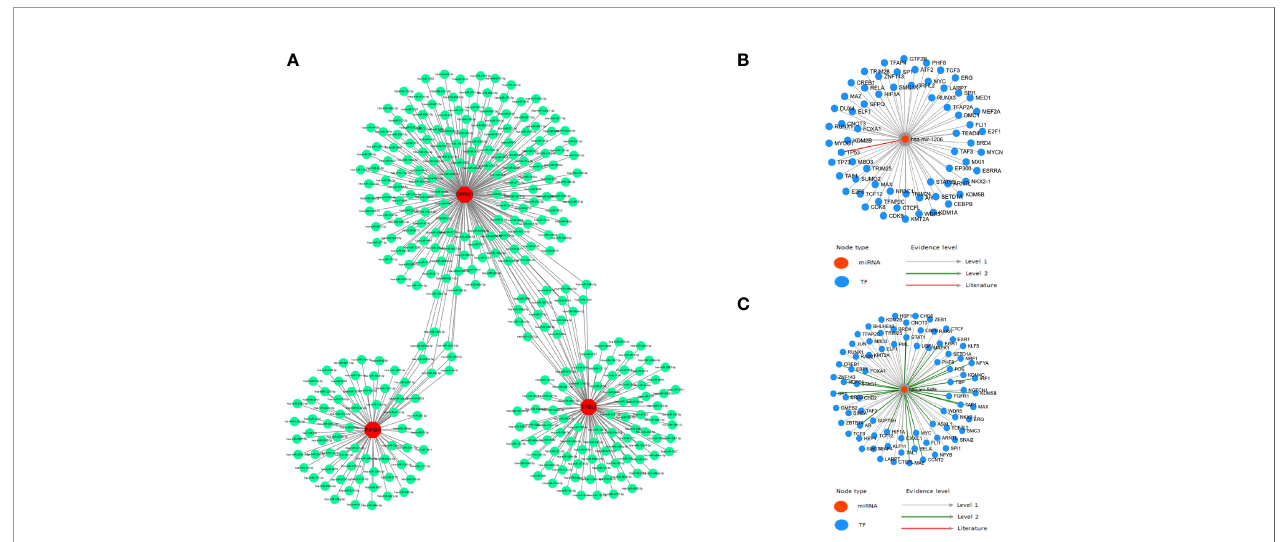
FIGURE 7 | TF-miRNA regulations. (A) mRNA-miRNA relationship pairs; (B) has-miR-548k and associated TF regulation; (C) has-miR-1206 and associated TF